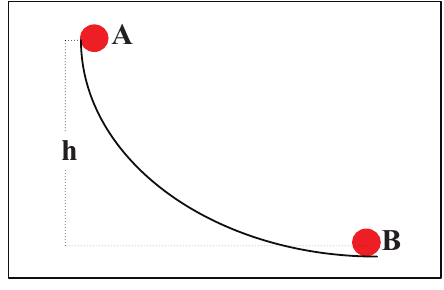
Figure 2: The process from potential energy to power